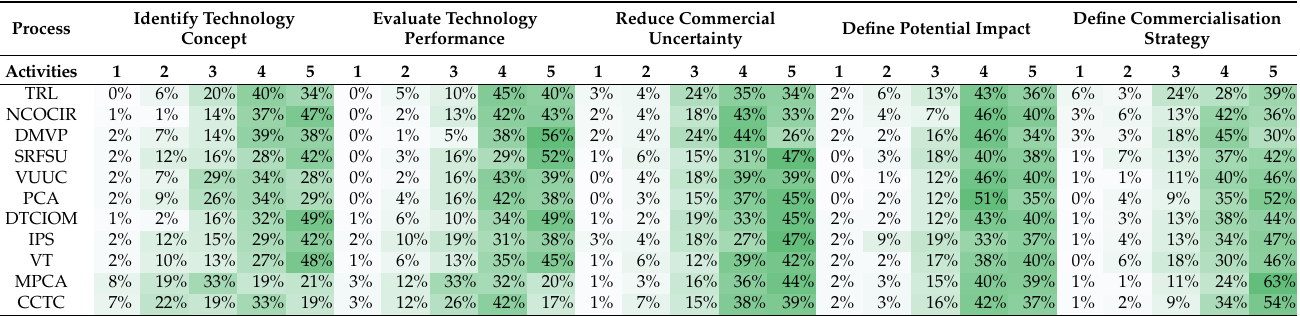
Table 2. Importance of the activities in the POVD; acronyms can be found in Sections 2.1 and 3.1.